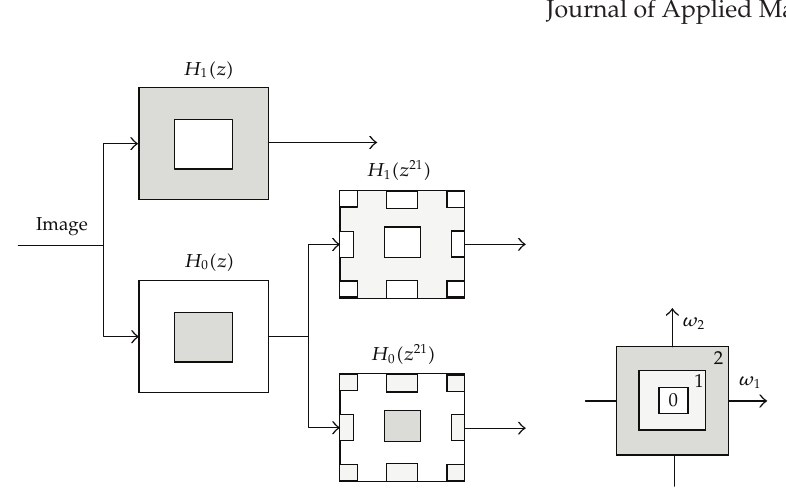
Figure 3: Non-subsampled pyramid decomposition.